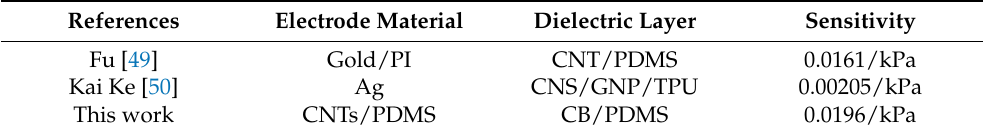
Table 2. Comparison of the proposed sensor with different sensors.